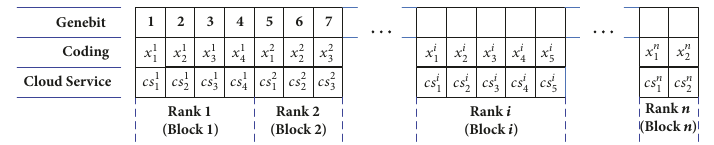
Figure 3: Schematic of encoding